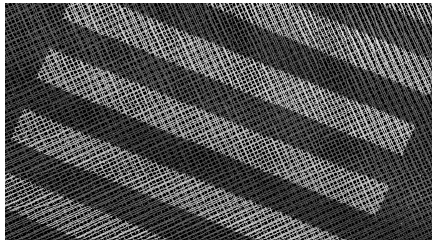
Figure 3. Example of LIDAR data by MX-8 (Crosswalk)